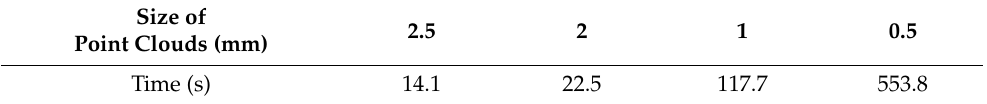
Table 6. Computation time of the PODs under different sizes of point